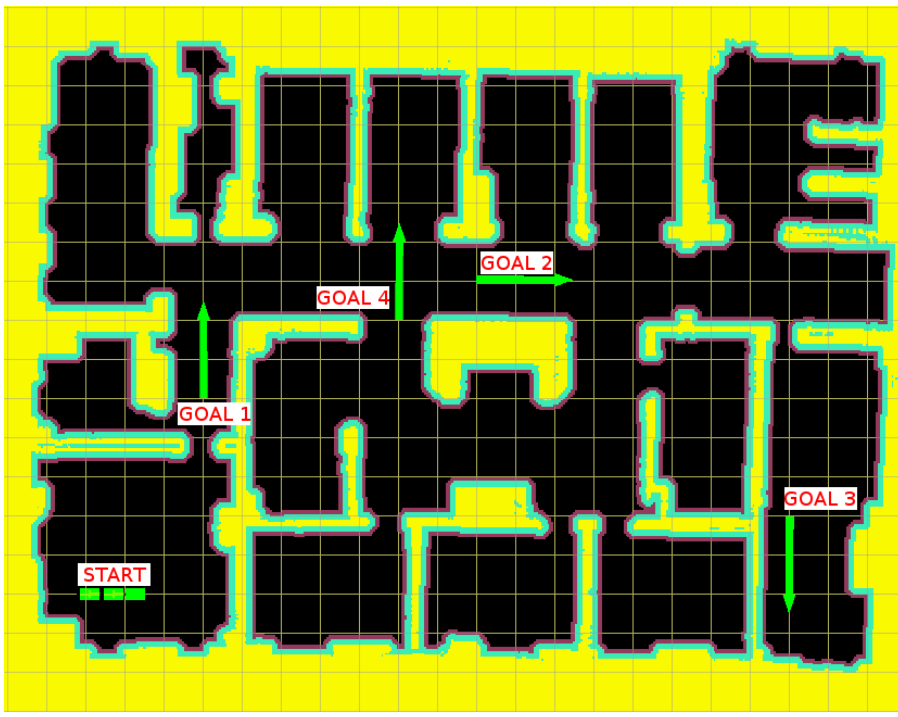
Figure 12. Goals selected for each set of